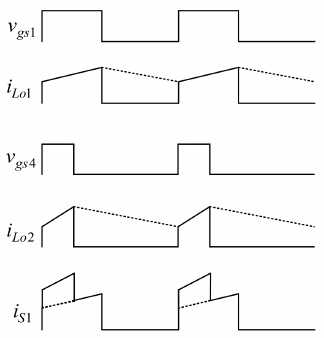
Figure 4. Trailing-edge modulation technique.